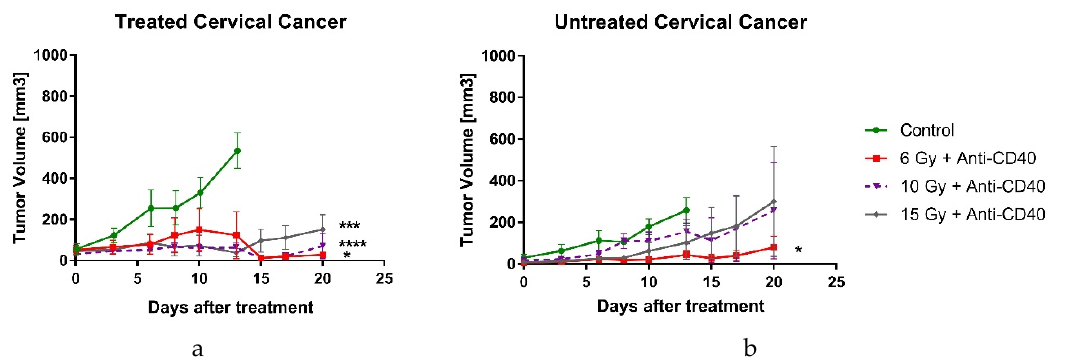
Figure 3. Radiation dose titration study in cervical cancer. C57BL/6 mice were subcutaneously inoculated with TC-1 cells on both flanks. Once tumors reached a 3-4 mm size, the right tumors were treated with a single dose of 6 Gy, 10 Gy or 15 Gy, with a combination of agonistic anti-CD40 (20 µg/tumor) ( a ) Volumes of treated tumors over time. Higher doses of RT had a better treatment impact, but did not induce the abscopal effect. ( b ) Volumes of untreated (abscopal) tumors over time. Single dose of 6 Gy combined with anti-CD40 induced abscopal effect on contralateral tumor, by inhibiting tumor progression. Error bars are SEM. n = 5 mice/group. * p < 0.05, *** p < 0.001, **** p < 0.0001.